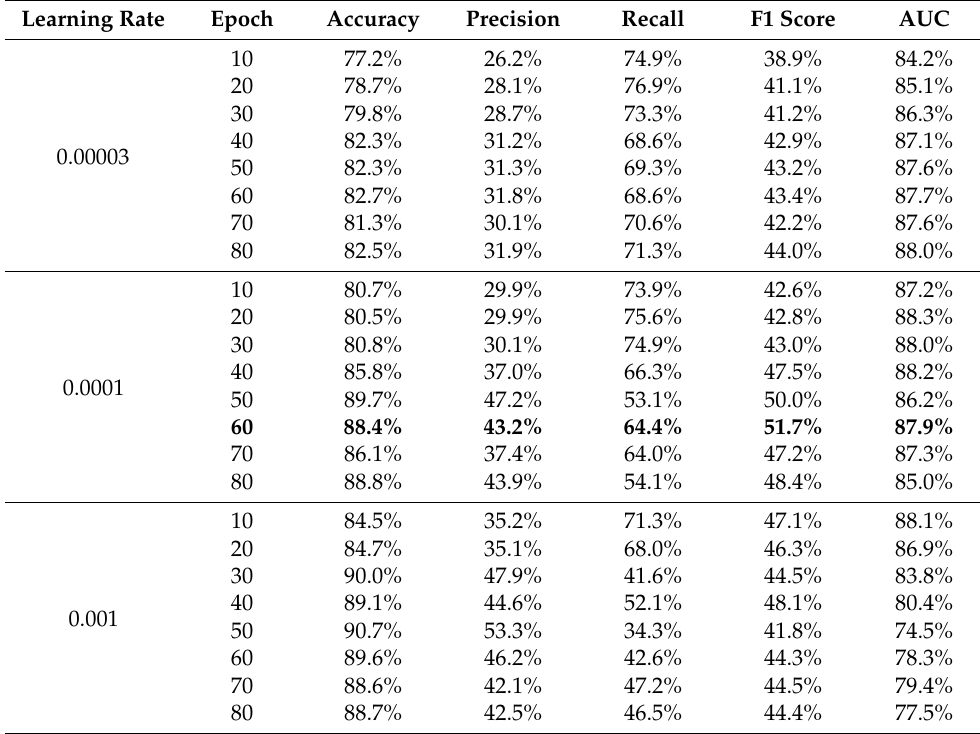
Table 1. Performance of the Bi-LSTM-128 models on the development set.